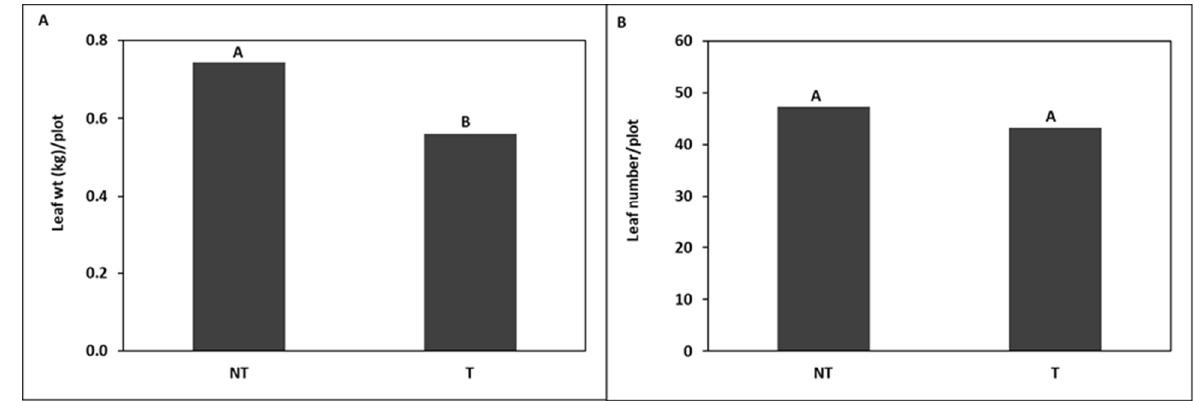
Figure 13. Effect of trap cropping on kale ( A ) leaf weight; ( B ) leaf number in Kale Trial I. Means followed by the same letters are not different based on analysis of variance.